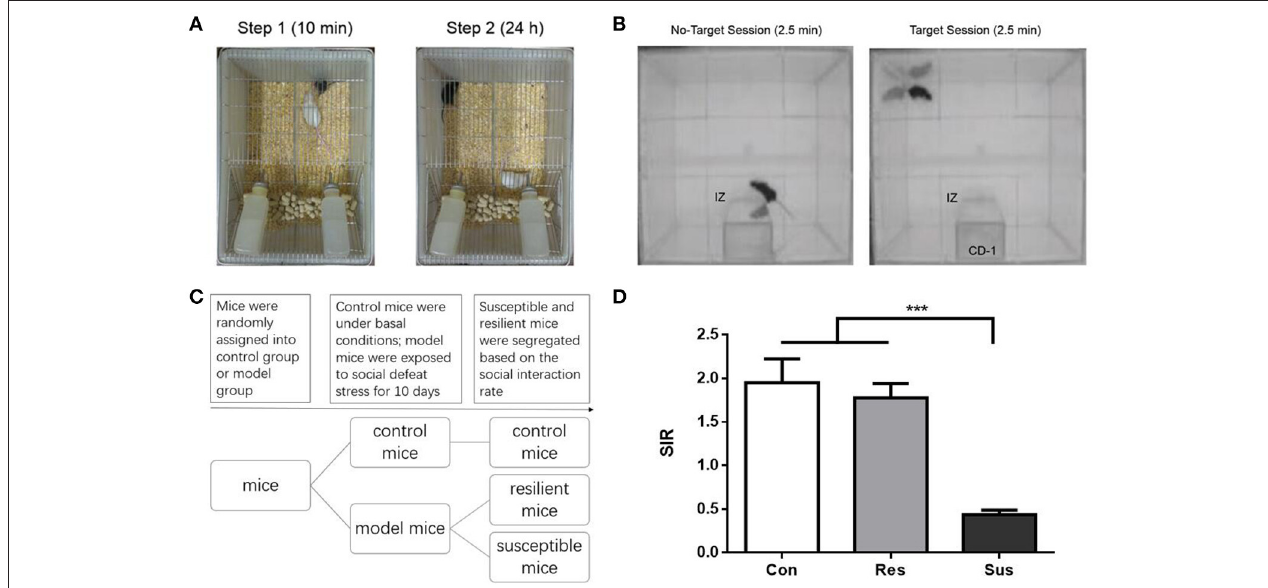
FIGURE 1 | The schematic diagram of the experimental process for chronic social defeat stress and social interaction test as well as the social interaction ratio in the social interaction test. (A) The schematic diagram of the experimental process for chronic social defeat stress. (B) The schematic diagram of the experimental process for social interaction test. (C) The experimental procedure of the first experiment. (D) The social interaction rate in the social interaction test [ n (Con) = 20; n (Res) = 18; n (Sus) = 20]. All data are shown as mean ± s.e.m. *** P < 0.001. Con, Control; Res, Resilient; Sus,